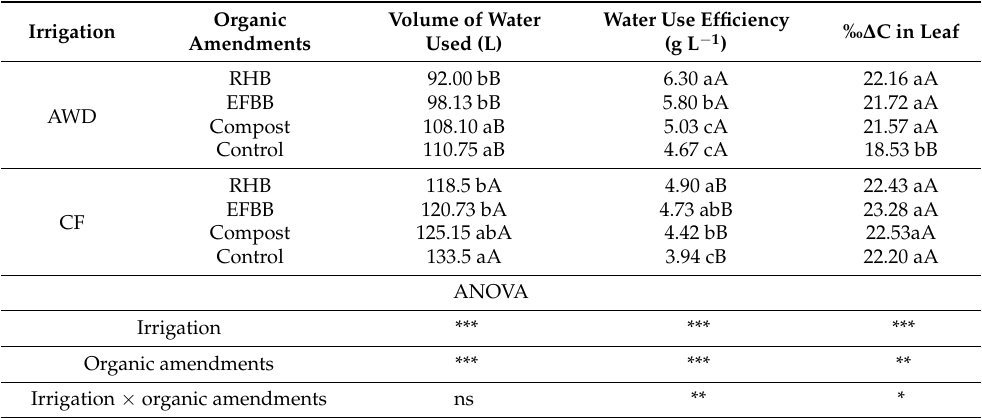
Table 2. Effect of irrigation management and organic amendments on irrigation water volume, water use efficiency and leaf carbon isotope discrimination of